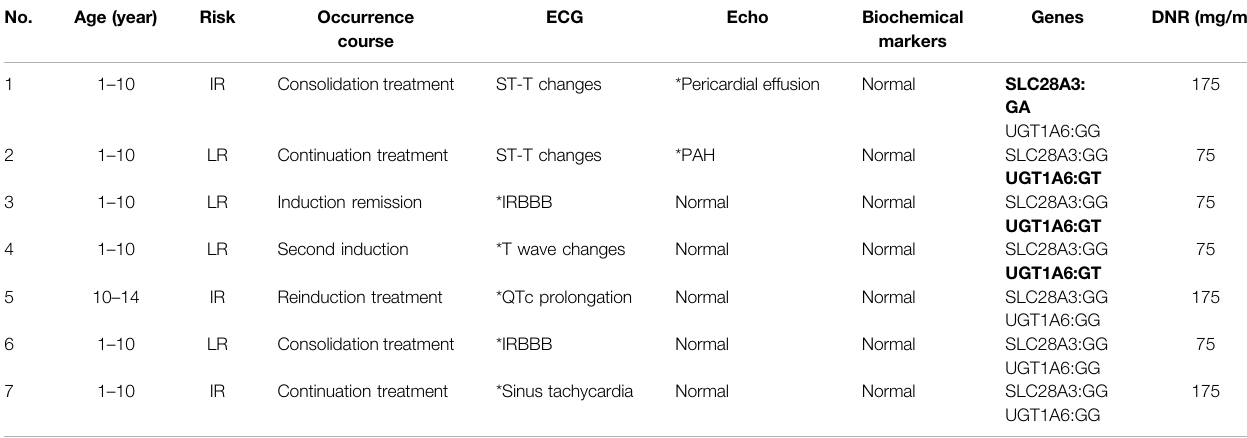
TABLE 5 | Clinical characteristics of the unrecovered patients. The unrecovered parameters are marked with an asterisk (*). ECG, electrocardiogram; Echo, echocardiography; DNR, daunorubicin; M, male; F, female; LR, low risk; IR, intermediate risk; IRBBB, incomplete right bundle branch block; PAH, pulmonary arterial